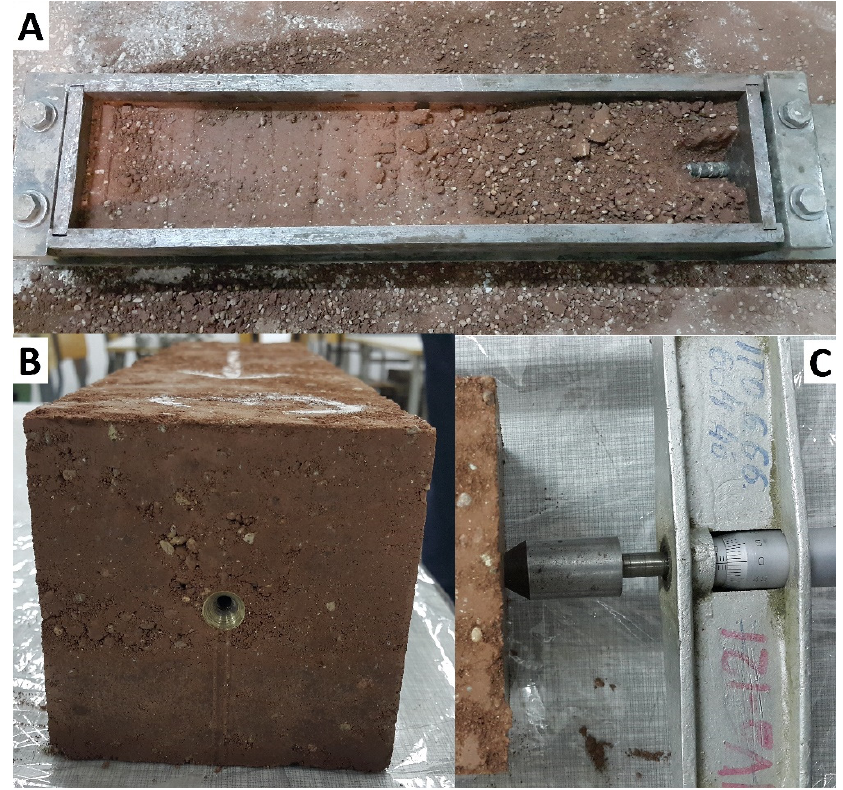
Figure 4. Rammed earth linear shrinkage test. ( A )—the method of assembling a steel peg after ramming the second layer of the sample. ( B )—the location of the steel peg in the soil sample for the linear shrinkage test. ( C )—micrometer screw, on which the length of the samples was read with an accuracy of 0.01 mm.